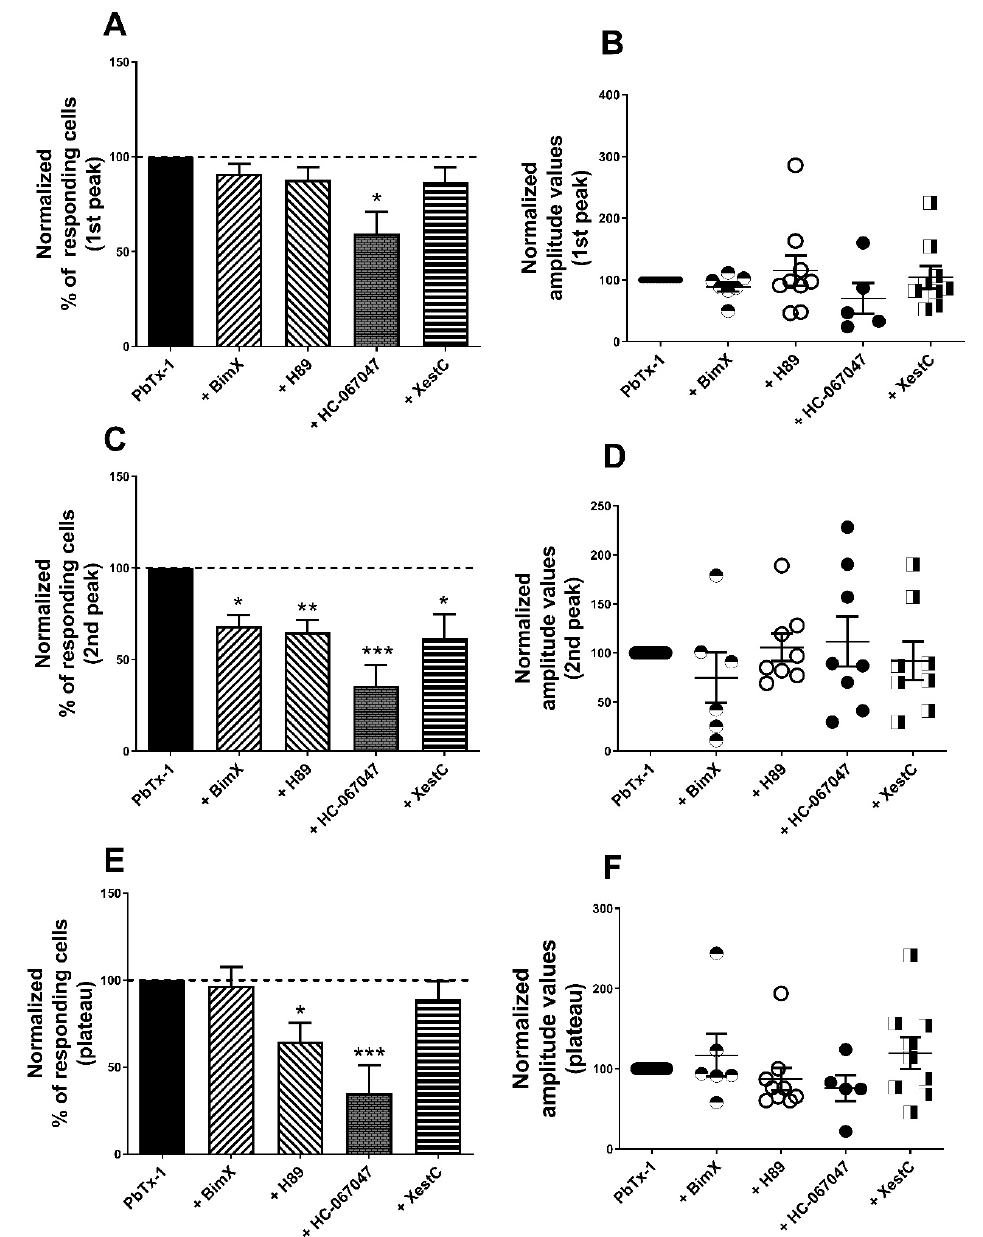
Figure 5. Effects of PKC, PKA, IP3R and TRPV4 antagonists on PbTx-1-induced [Ca 2+ ] i increase in sensory neurons. Normalized percentages of responding cells and normalized associated amplitude values recorded for the first transient ( A , B ), the second transient ( C , D ) and the plateau ( E , F ) in response to 1 µM of PbTx-1 alone (control condition (100%), n = 15) or with pretreatment with 10 µM of BimX (n = 7), 5 µM of H89 (n = 9), 10 µM of HC-067047 (n = 5), and 5 µM of XestC (n = 9) were expressed as mean ± SEM. The “n” represents the number of experiments in which 50 to 150 neuronal cells were included in the analysis. In the right panels, each symbol represents the normalized mean of the maximal amplitude values from the responding neurons obtained in each experiment. The statistical analysis was performed with performed with a Kruskal–Wallis followed by Dunn’s test for multiple comparisons between control and each condition. * p < 0.05, ** p < 0.01 and *** p < 0.001. BimX: bisindolylmaleimide X hydrochloride; IP3R: inositol triphosphate receptor; PbTx-1: brevetoxin-1; PKA: protein kinase A; PKC: protein kinase C; TRPV4: transient receptor potential vanilloid 4; XestC: xestospongin